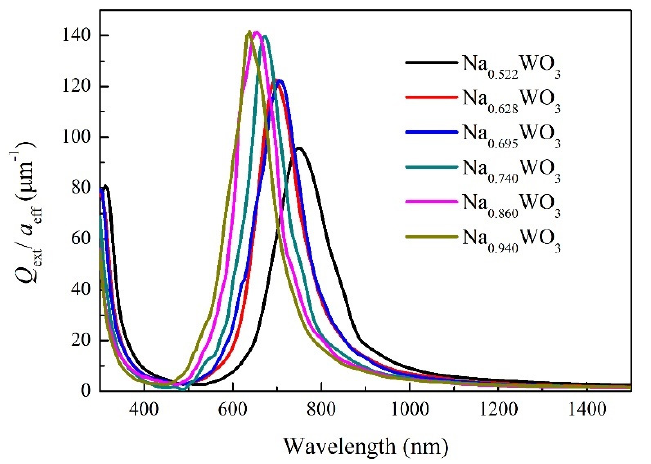
Figure 7. Extinction curves of sphere-shaped Na x WO 3 particles with size of 50 nm and different x x value.